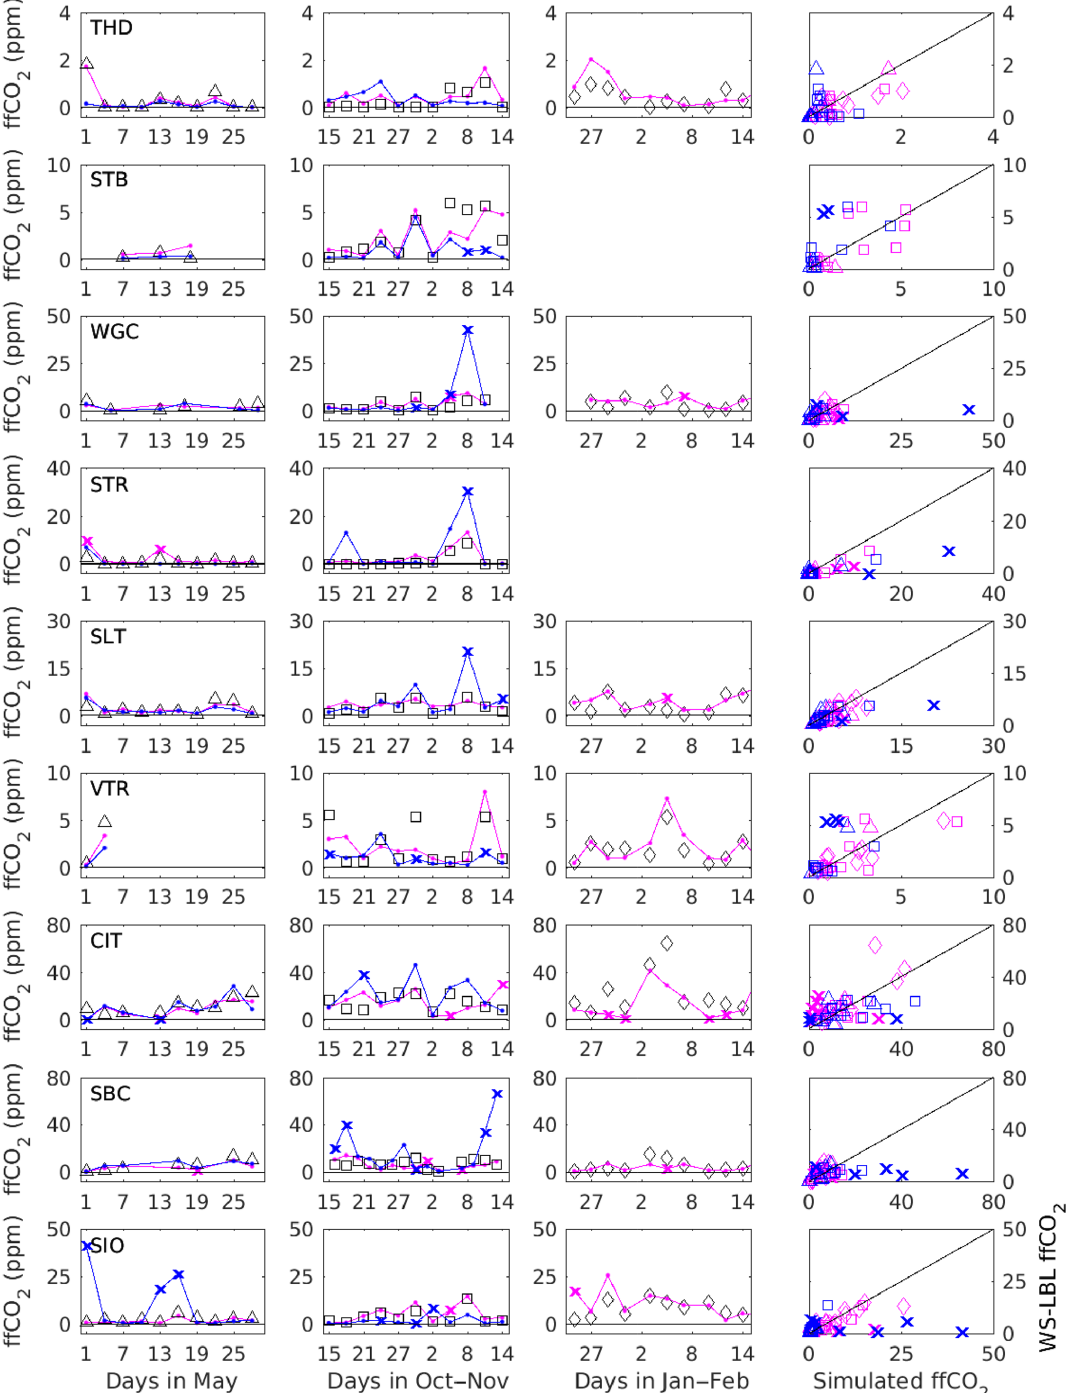
Figure 7. All simulated ffCO 2 from May (first column), October–November (second column), and January–February (third column). Sim- ulated ffCO 2 values using WS-LBL are shown in black markers (triangles for May, squares for October–November, and diamonds for January–February), whilst prior WS-CTL signals are shown in blue and UM-NAME signals are shown in magenta. All simulated signals are generated using the Vulcan gridded emission map. The fourth column shows true vs. prior ffCO 2 signals, with colours corresponding to models and markers corresponding to campaigns. Outliers omitted from the standard inversion are shown with an